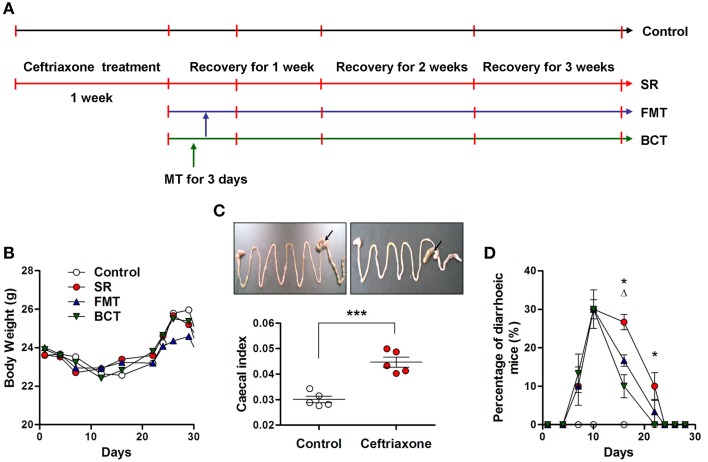
Schematic overview of ceftriaxone treatment and FMT/BCT. (A) To establish the intestinal dysbiosis model, BALB/c mice were treated with ceftriaxone sodium for 7 days. After that, they were divided into 3 experimental groups: the spontaneous recovery group (SR), the fecal microbiota transplantation group (FMT), and the bacterial consortium transplantation group (BCT). The red vertical bars indicate sampling dates. The recovery of intestinal ecosystem was observed for 3 weeks. (B) Mean body weights, (C) Cecal index, and (D) The number of mice with diarrhea were investigated respectively. ***p < 0.001; *, FMT compared with SR, p < 0.05; Δ, BCT compared with FMT, p < 0.05.